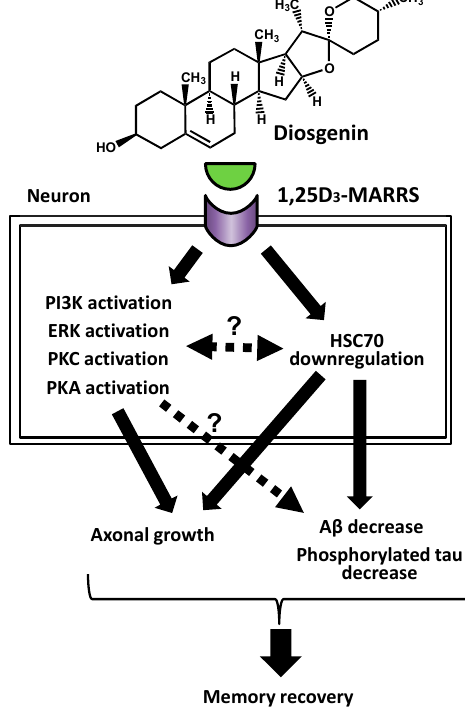
Figure 3. Signaling mechanism of diosgenin-induced memory recovery in Alzheimer’s disease models [63,71,72].